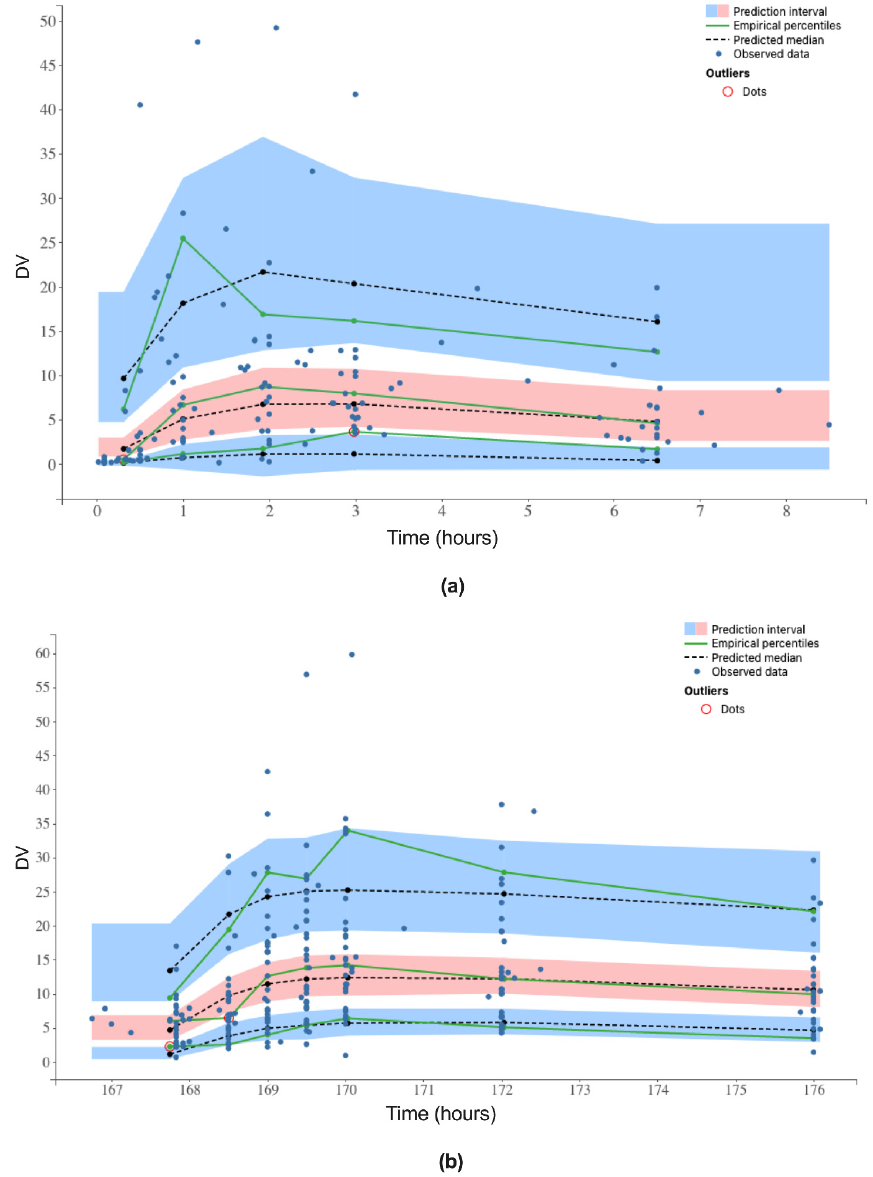
Figure 3. Visual predictive check plots of sirolimus observed concentrations (dependent variable DV in µg/L) versus time after the first sirolimus dose ( a ) and on D8 ( b ). Blue areas are 95% confidence interval of the 10th and 90th percentiles. The pink area is the confidence interval of the median. Black dotted lines represent means of the 10th, 50th, and 90th predicted percentiles. Blue dots represent observations and green continuous lines represent means of the 10th, 50th, and 90th observed percentiles. Red circles show deviations of the predicted data from the observations.